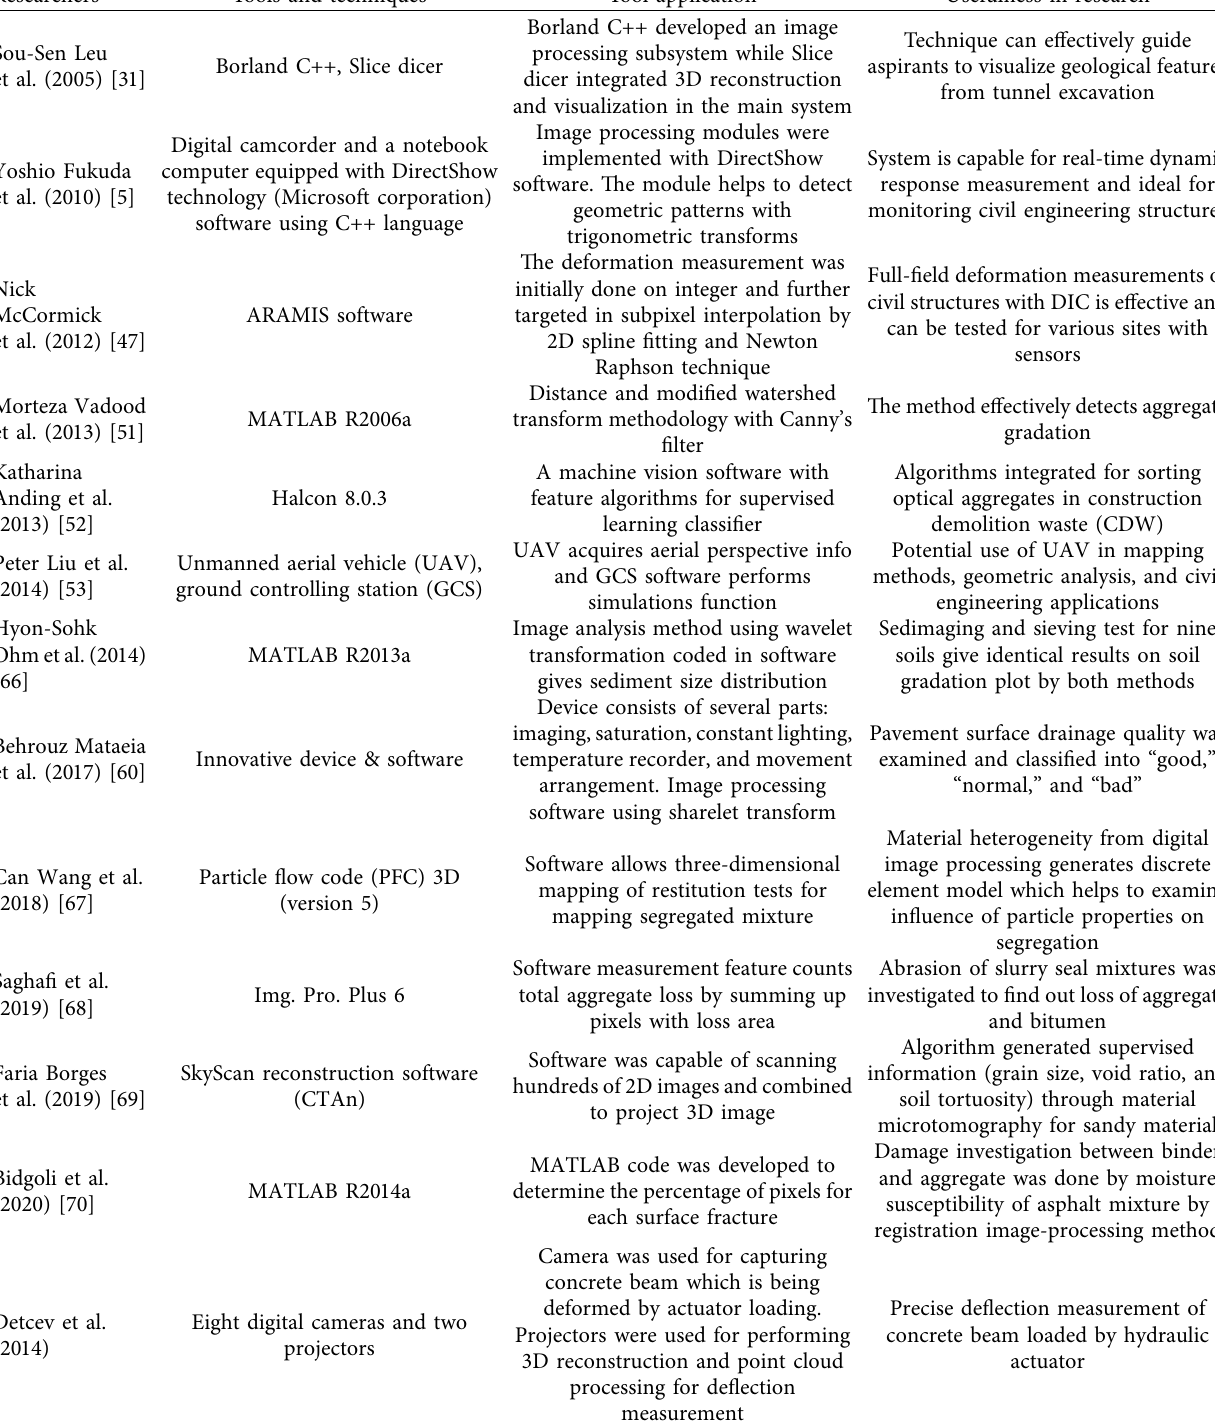
Table 1: Image processing tools in civil engineering